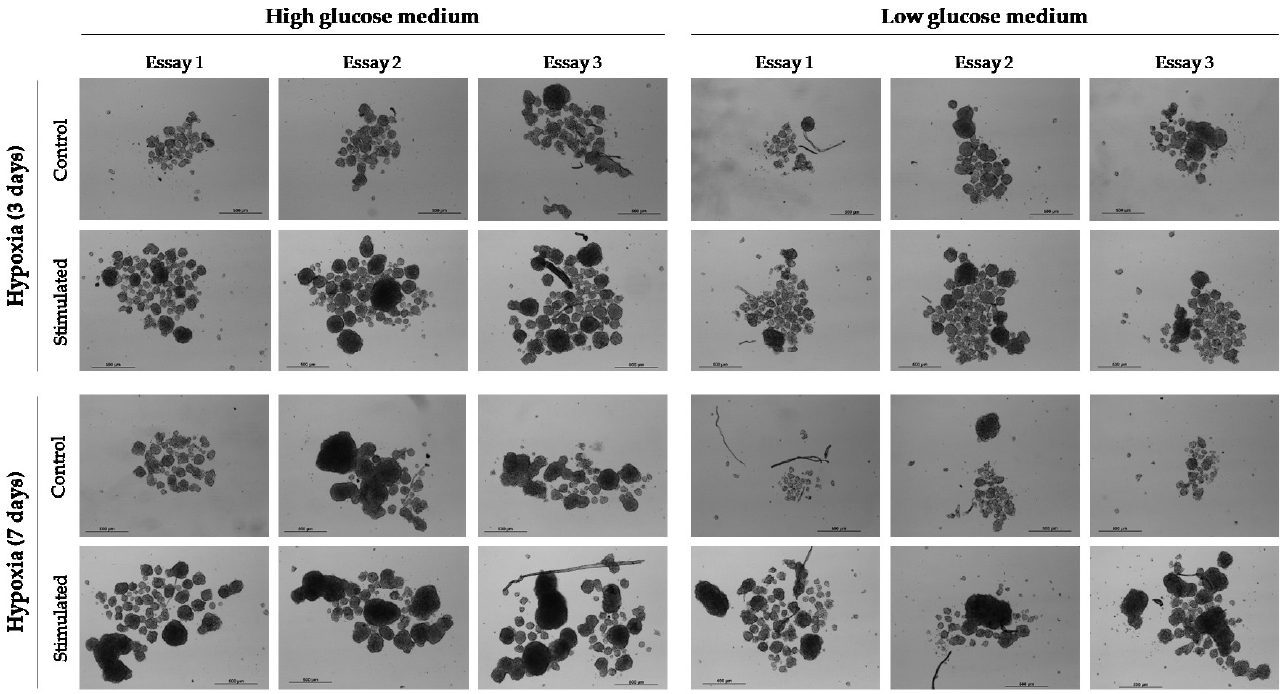
Figure 5. Effect of hypoxia (1% O 2 ) and glucose deprivation (1 g/L (low glucose)) on the development and growth of spheroids from cell line HepG2. Cell culture conditions were maintained for 3 or 7 days. Thereafter, standard culture conditions (normoxia and 3.15 g/L glucose (high glucose)) were maintained. Images at 10x were taken 11 days after cell culture. In order to compare the effect of oxygen supply on the growth of spheroids from CTCs, 10 samples of enriched CD45 – cells were maintained under normoxia and hypoxia. We observed spheroids in both culture conditions in two of these samples (Table 6). As we observed for the HepG2 cell line, hypoxia stimulated the growth of cCSC spheres (Figure 6). Despite this, the spheroids started to die off rapidly after 7–10 days of ex vivo culture.